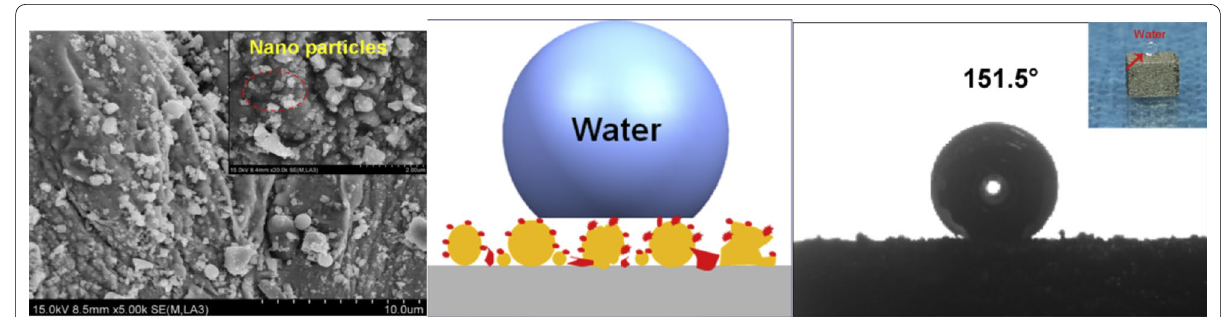
Figure 16 The superhydrophobic surface of laser AM NMCs[81]. a Morphology of the surface; b Schematic diagram of the wetting model; c Contact angle images of TiC/Inconel 718